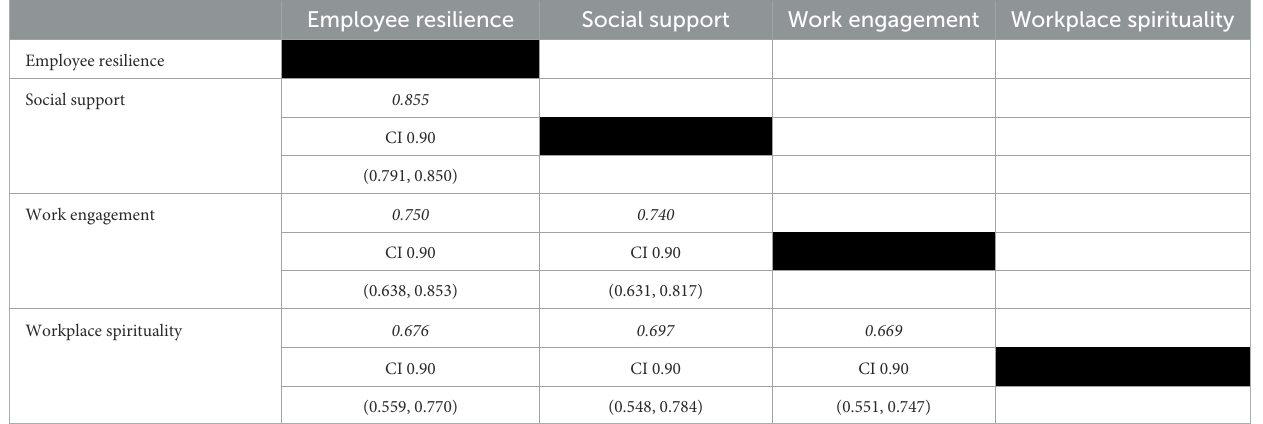
TABLE 2 The measurement model discriminant